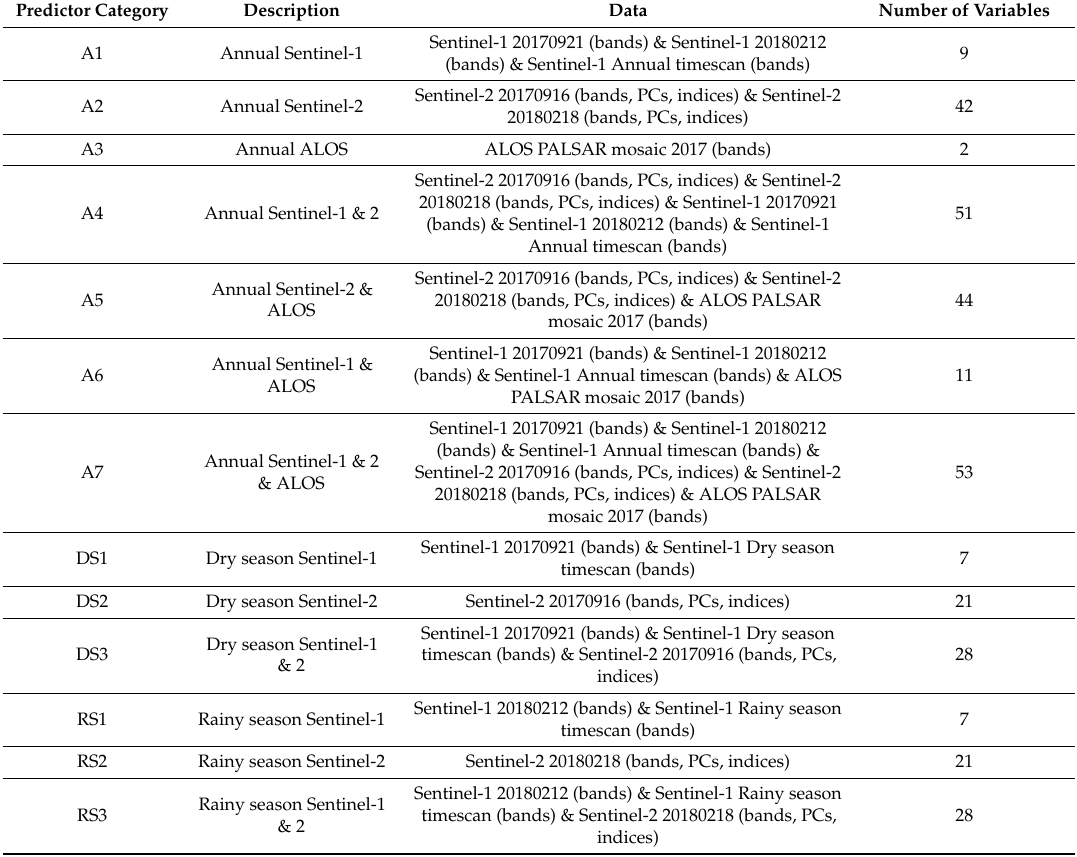
Table 4. Data and predictor variable categories used for